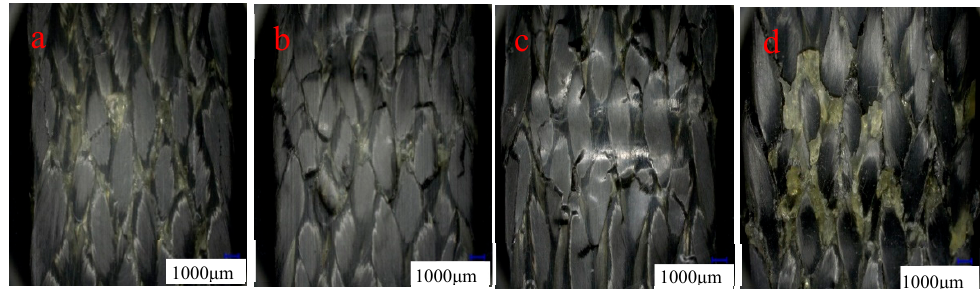
Figure 13. Pressure surface morphology of bending fracture of specimens at different temperatures (20 times magnification) ( a ) at room temperature; ( b ) 90 °C 0.25 h; ( c ) 110 °C 0.25 h; ( d ) 150 °C 0.25 h.